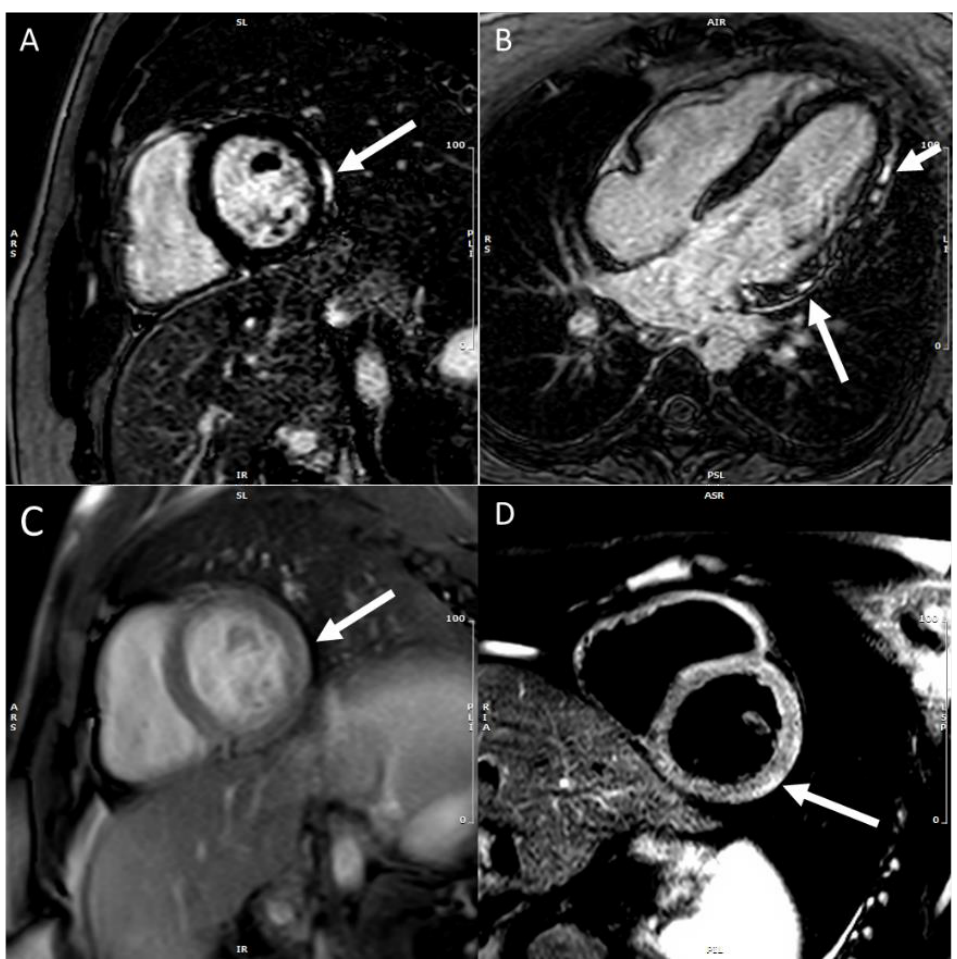
Figure 10. A 16-year-old-male with mRNA COVID-19 vaccine-associated myocarditis. ( A ) subepicardial LGE (white arrow); ( B ) subepicardial LGE (white arrow); ( C ) early gadolinium enhancement (EGE) (white arrow); and ( D ) shows enhanced T2 signal (white arrow).